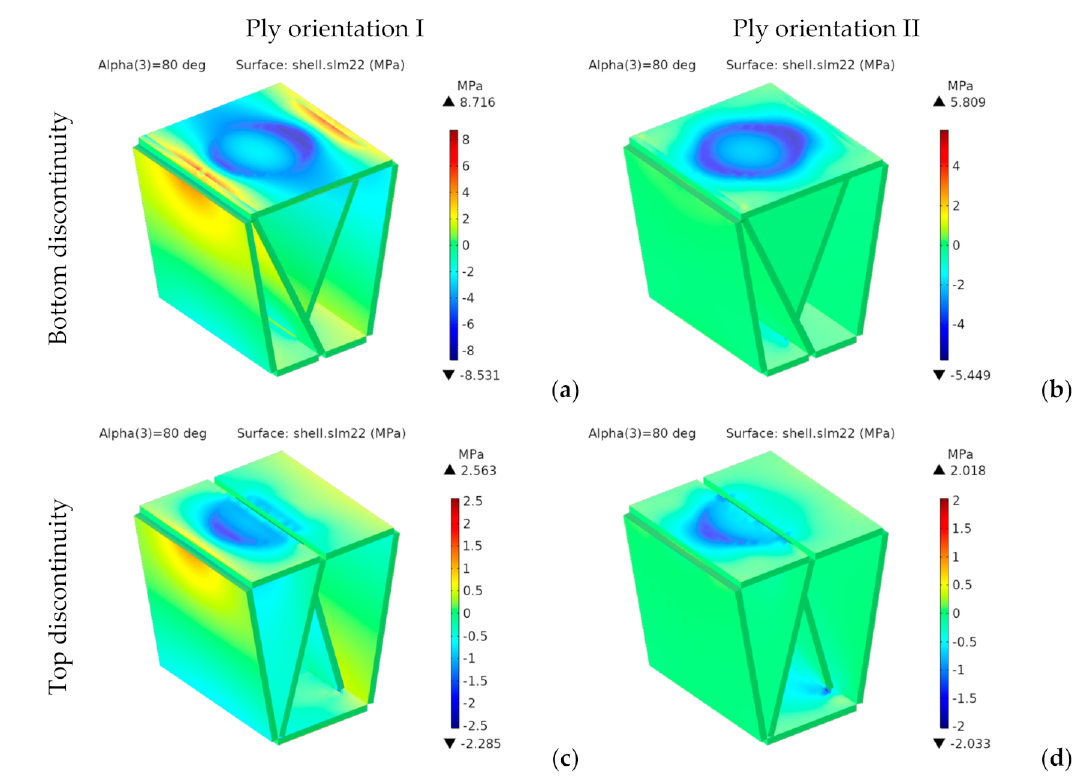
Figure 24. 2nd design. Stress σ yy [MPa] for bottom ( a , b ) and top ( c , d )